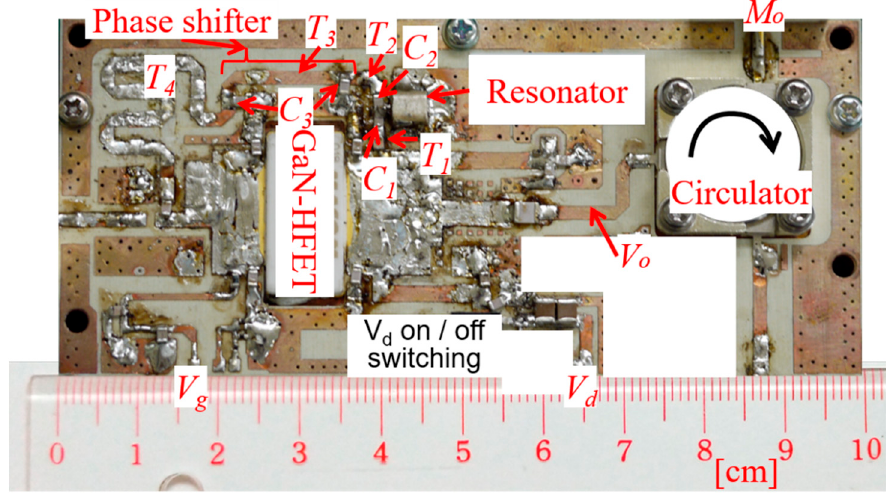
Figure 9. Photograph of the high power oscillator module.